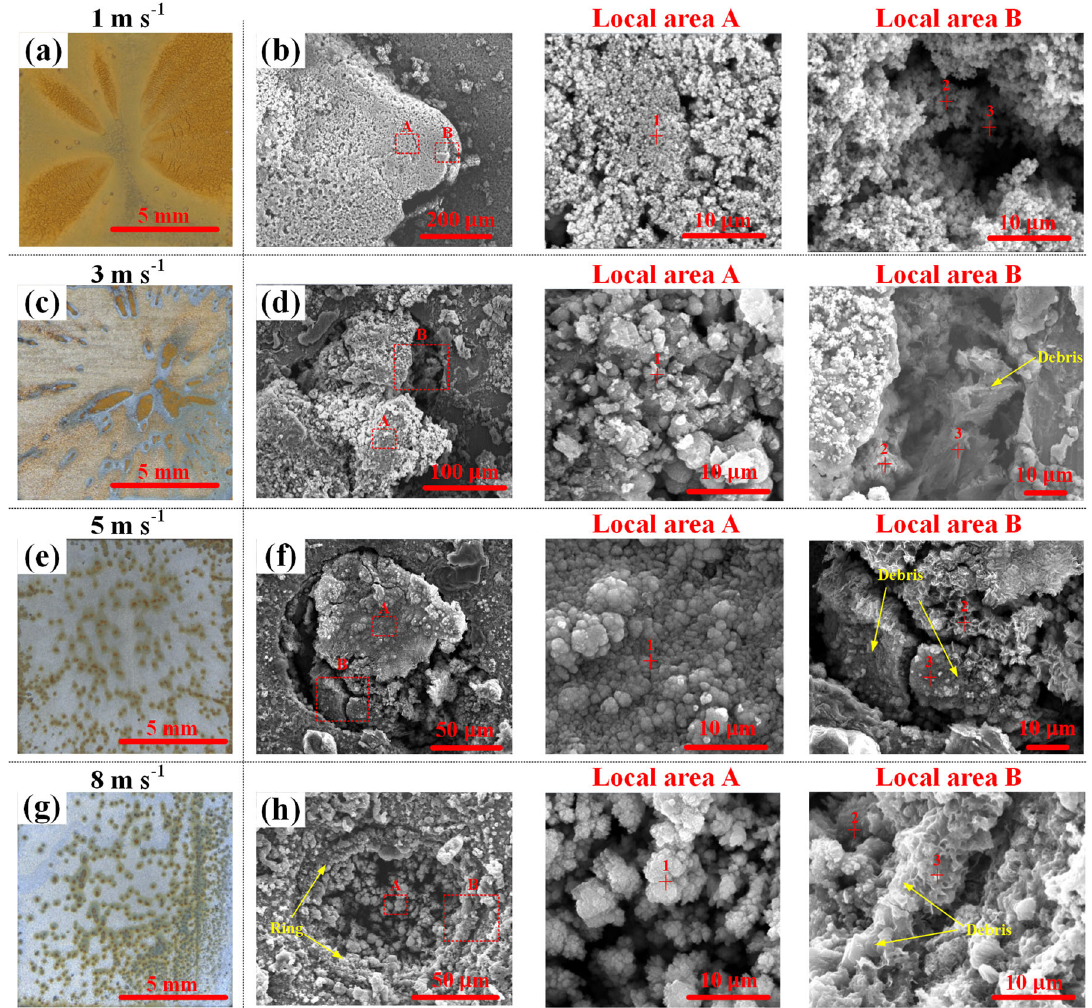
Fig. 8 Surface morphologies of the steel samples after tested in natural seawater containing sand particles. Photos ( a , c , e , g ) and SEM images ( b , d , f , h ) of the samples after erosion − corrosion tests at different fl ow velocities. a , b 1 m s − 1 , c , d 3 m s − 1 , e , f 5 m s − 1 , g , h 8 m s − 1